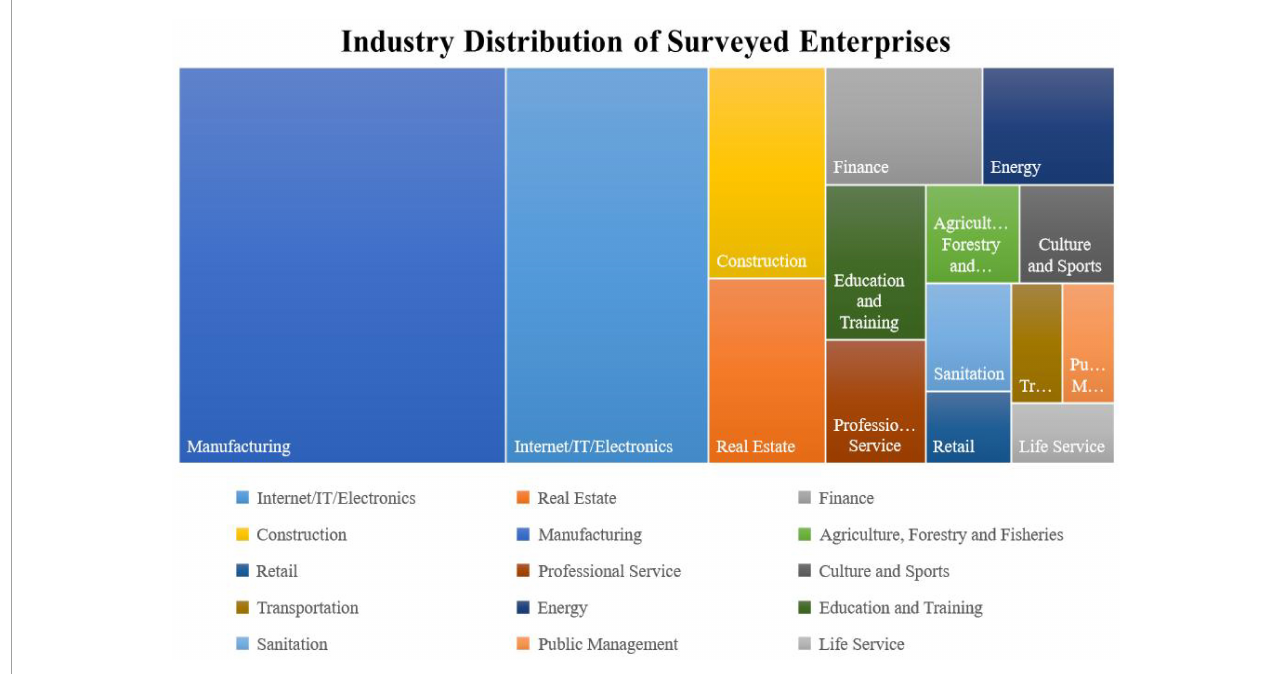
FIGURE4 Industry distribution of surveyed enterprises.